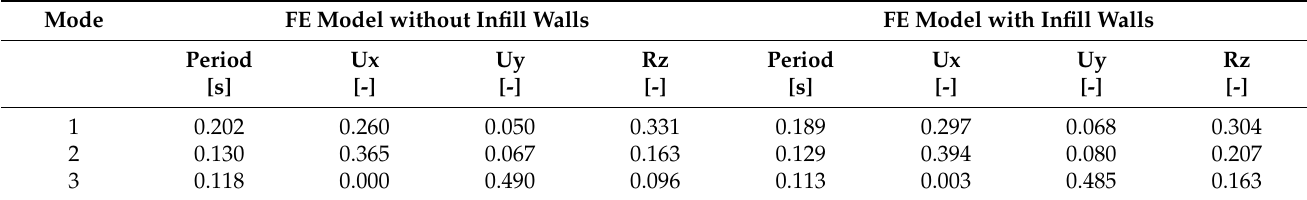
Table 5. Modal Participating Mass